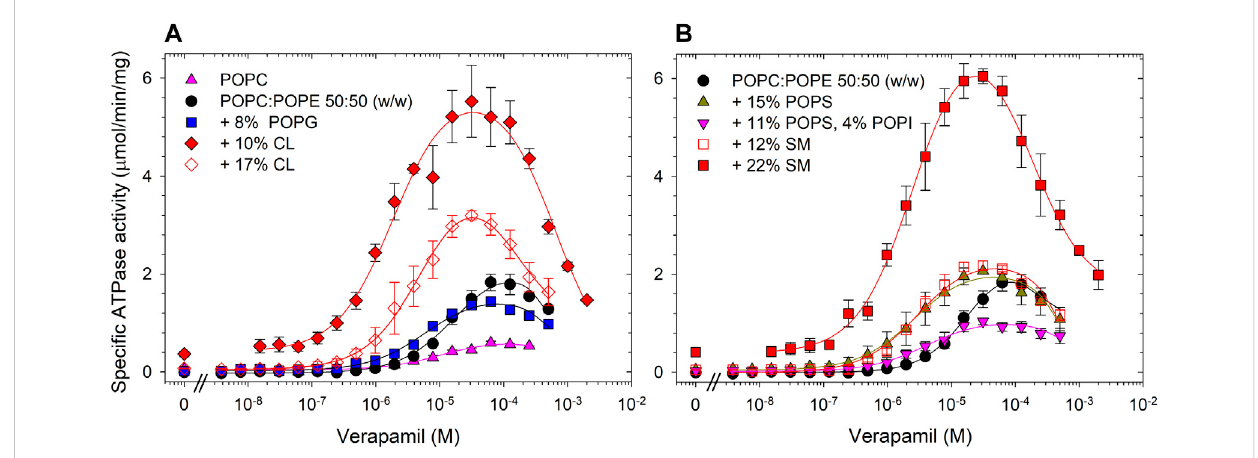
FIGURE 2 Effectsofphospholipidheadgroupsontheverapamil-stimulationofATPase. (A) Lipidcomponentsof E.coli polarlipids,and (B) phospholipidsfound in mammalian plasma membranes. Puri fi ed Pgp was activated with 10 mM DTT and 1% POPC:POPE (50:50, w/w) lipid supplemented with indicated phospholipids as described in Experimental Procedures. Data points represent the mean ± SEM ( n = 3). Kinetic parameters obtained from fi ts (solid lines) to the data points are listed in Table 2.